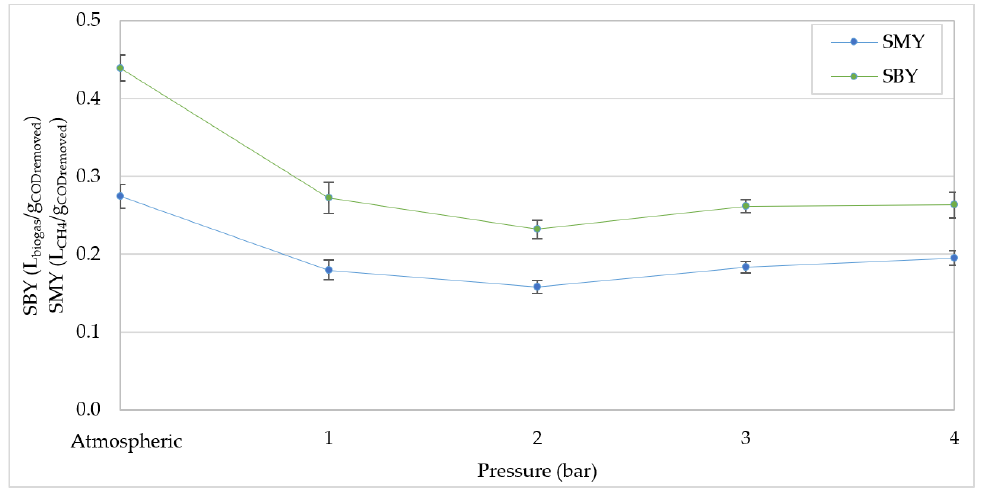
Figure 7. Specific biogas yield (SBY) and specific methane yield (SMY) at increasing pressures for organic load rate (OLR) of 30 kg COD /m 3 d.